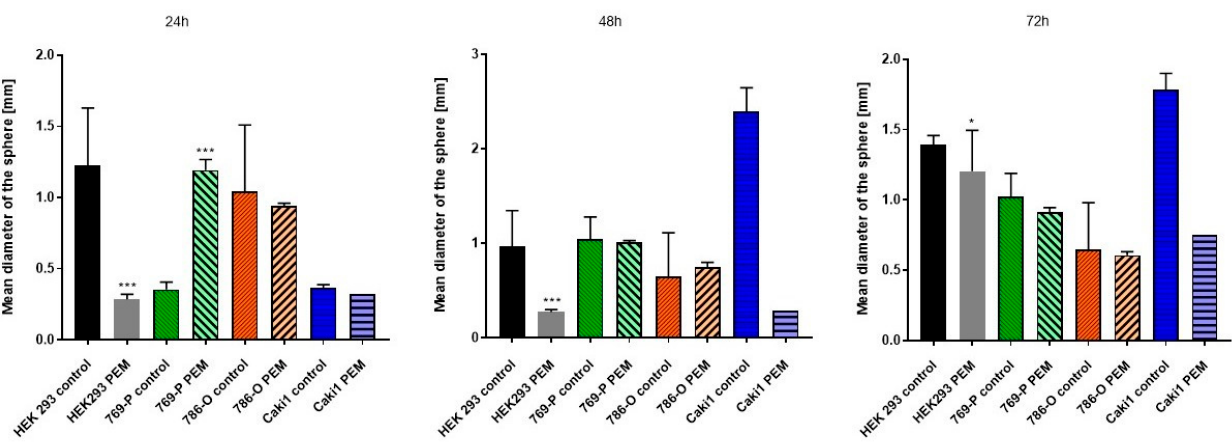
Figure 4. Number of cells migrating towards chemoattractant (average of 5 fields at 100x total magnification). (***— p < 0.0005; ****— p < 0.00005).